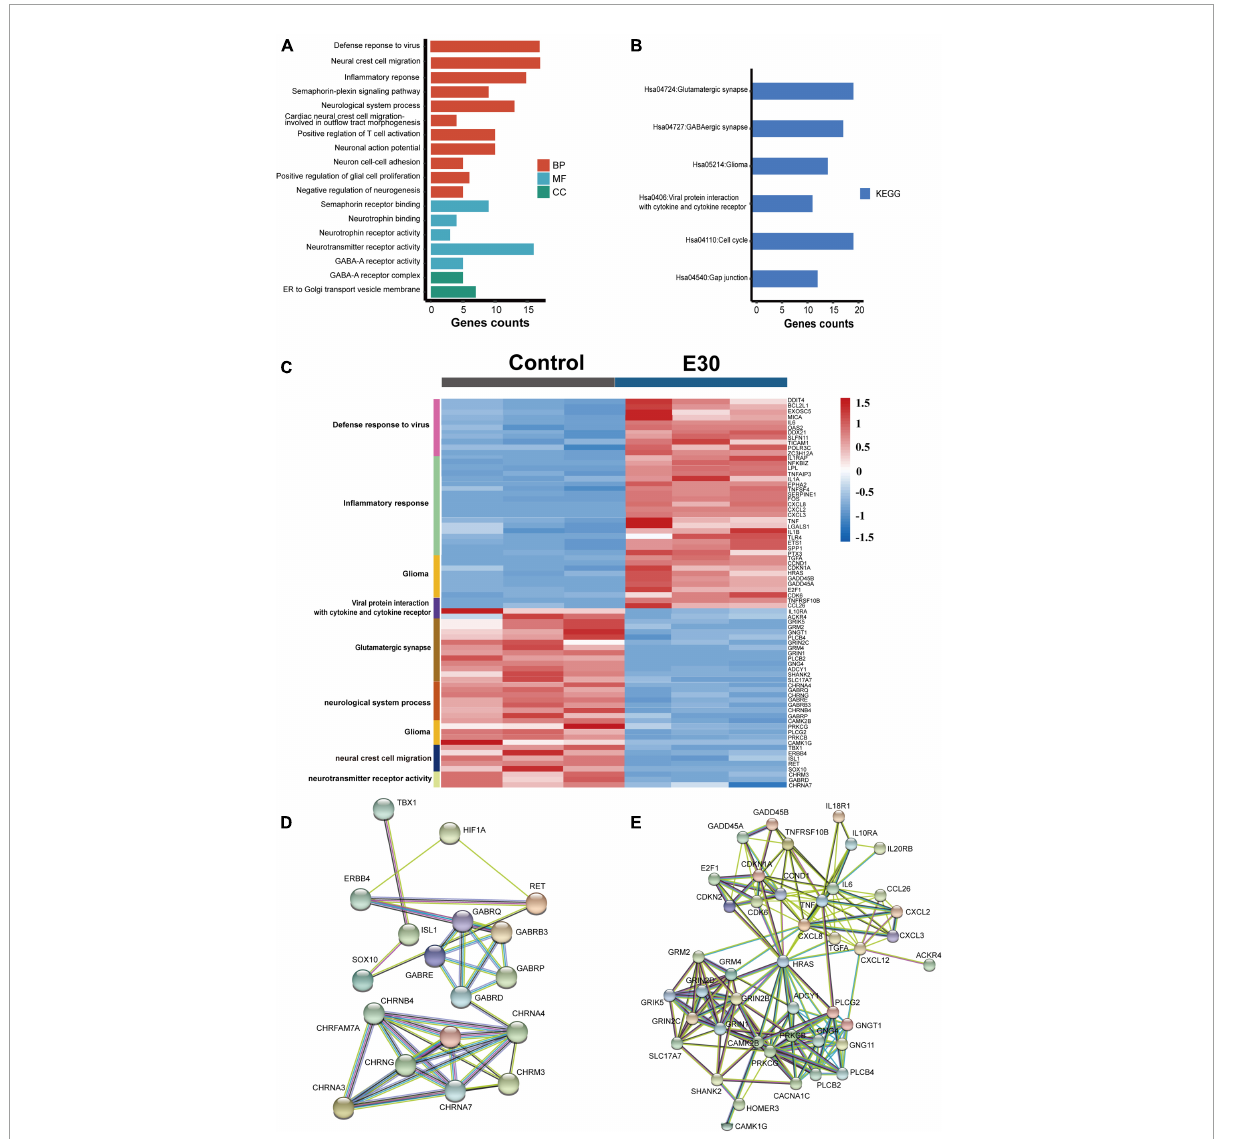
FIGURE2 Functional classification of differentially expressed genes (DEGs) in E30-infected human glioma (U251) cells. (A) Gene Ontology (GO) enrichment analysis of DEGs. (B) Kyoto Encyclopedia of Genes and Genomes (KEGG) pathway analysis of DEGs. (C) Visualization of DEGs enriched in E30-infected U251 cells. (D,E) Molecular interaction between DEGs and STRING randomly draws colors based on the scores of interacting genes and is labeled with gene